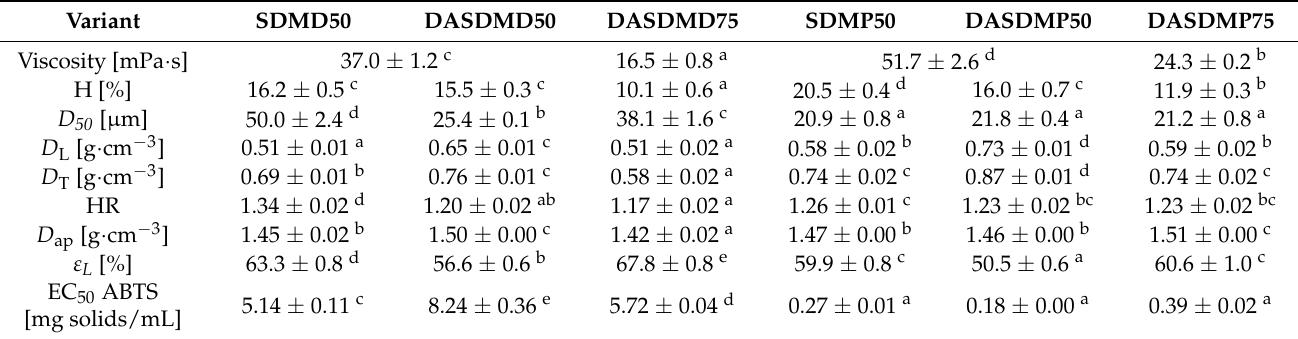
Table 3. Viscosity of feed solutions, physiochemical properties and antioxidant activity expressed as EC50 ABTS of buckwheat honey and powders containing 50 and 75% honey solids obtained with maltodextrin (MD) or milk powder (MP) as carriers by conventional spray drying (SD) and dehumidified-air-assisted spray drying (DASD).